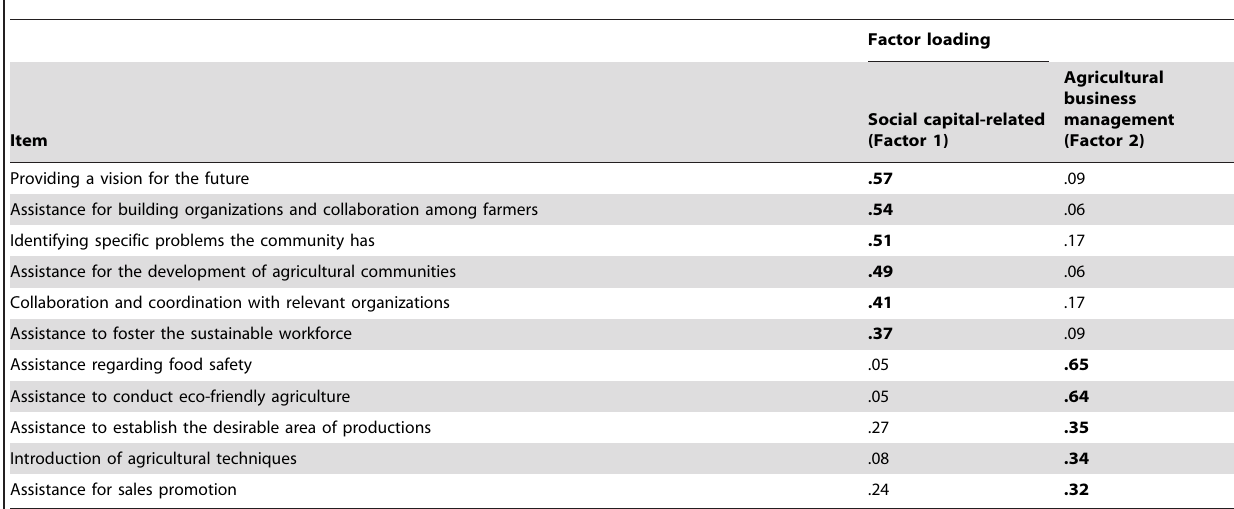
Table 3. Rotated factor matrix of the extension activity